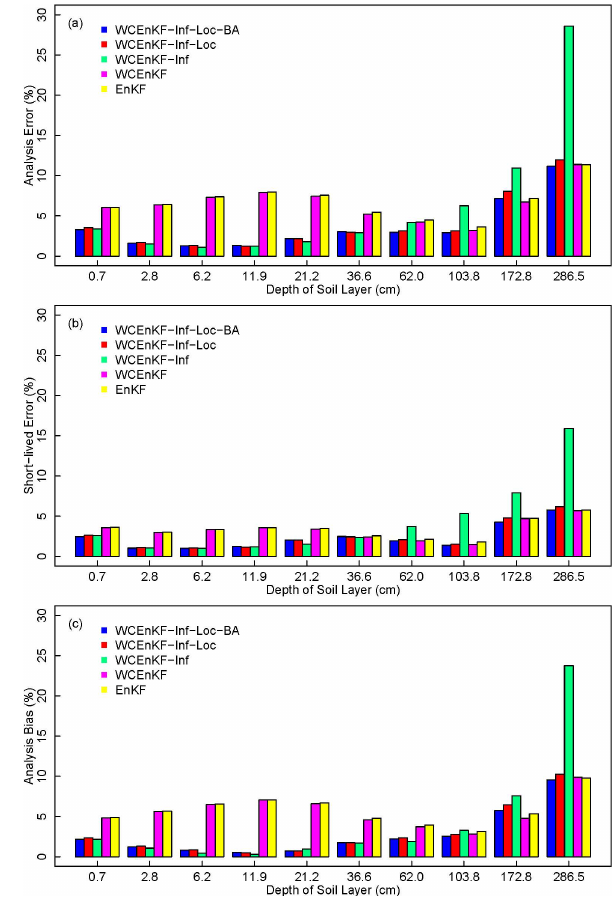
Figure 5. The assimilation results in each layer for the five schemes: a weakly constrained bias-aware ensemble Kalman filter with fore- cast error inflation and vertical localization (WCEnKF-Inf-Loc- BA), a weakly constrained ensemble Kalman filter with fore- cast error inflation and vertical localization (WCEnKF-Inf-Loc), a weakly constrained ensemble Kalman filter with forecast error infla- tion (WCEnKF-Inf), a weakly constrained ensemble Kalman filter (WCEnKF), and the traditional assimilation (EnKF). Graphic (a) is for spatial averaged analysis error of the soil moisture content, (b) is for the short-lived error and (c) is for the analysis